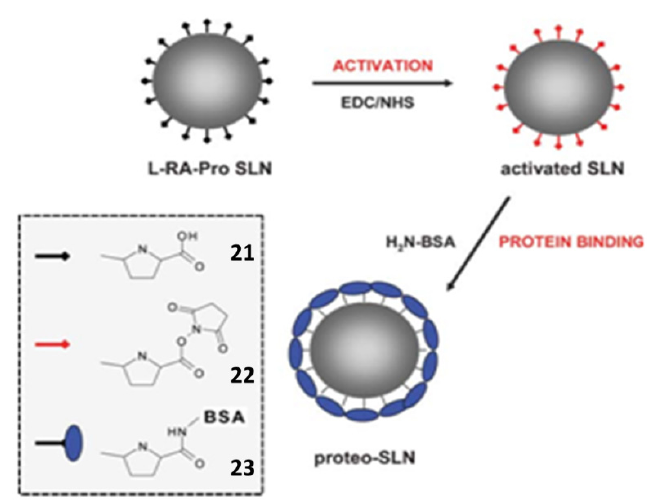
Figure 41. Synthetic route to proteo-SLNs 23 [120].